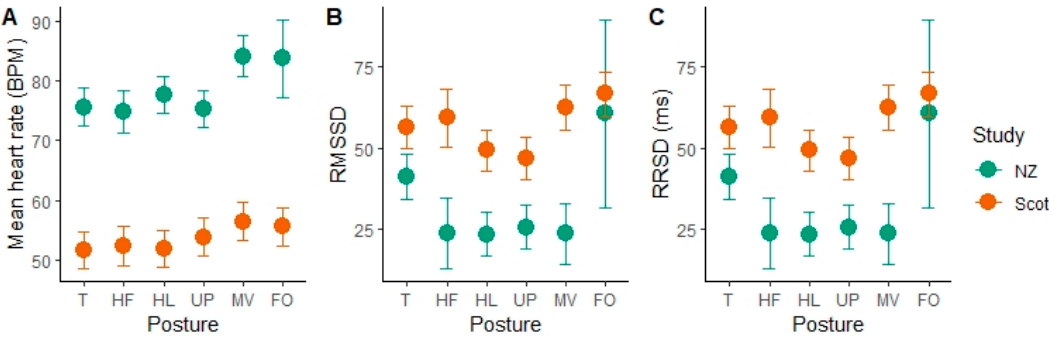
Figure 2. Plots of predicted means with error bars indicating standard error of the means for the mean heart rate in beats per minute (bpm) ( A ), the RMSSD ( B ) and SDRR ( C ) by lying postures (Tucked (T), head resting front (HF), head low (HL), head up (UP), moving (MV) and flat out (FO)) for the New Zealand group (NZ), Scottish group (Scot). Figure produced in R v4.0.5 using ggplot2 package (https://cran.r-project.org/web/packages/ggplot2/index.html, accessed on 3 May 2021).